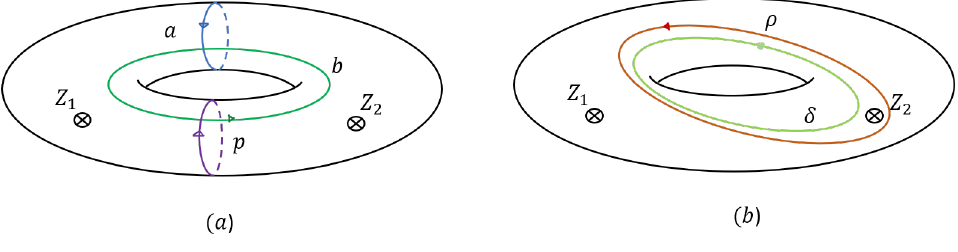
Figure 5 . (a) The curves defining the Dehn twists of the generator of PMCG (Σ 1 , 2 ) . (b) The curves associated with the generators of the ker Ω